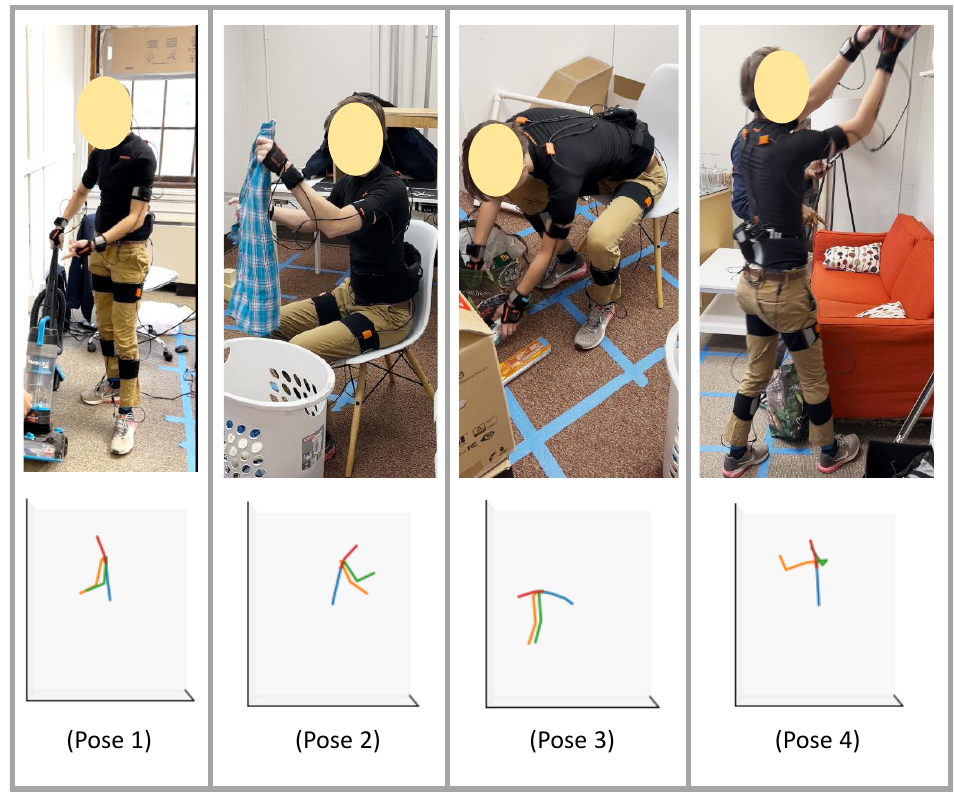
Figure 23. Figures in the first row are the samples of actual human poses during the different ADL tasks listed in Table A1. These include: vacuum cleaning (pose 1), folding laundry (pose 2), picking grocery items (pose 3), and putting objects on a high shelf (pose 4). In the second row, we present the skeleton model of the ground truth for the upper body for similar poses. The ground truth is reconstructed using the XSens MVN Link system. The actual human poses in the first row look slightly different than the ground truth poses in the second row because the photos correspond to slightly different times than the ground truth